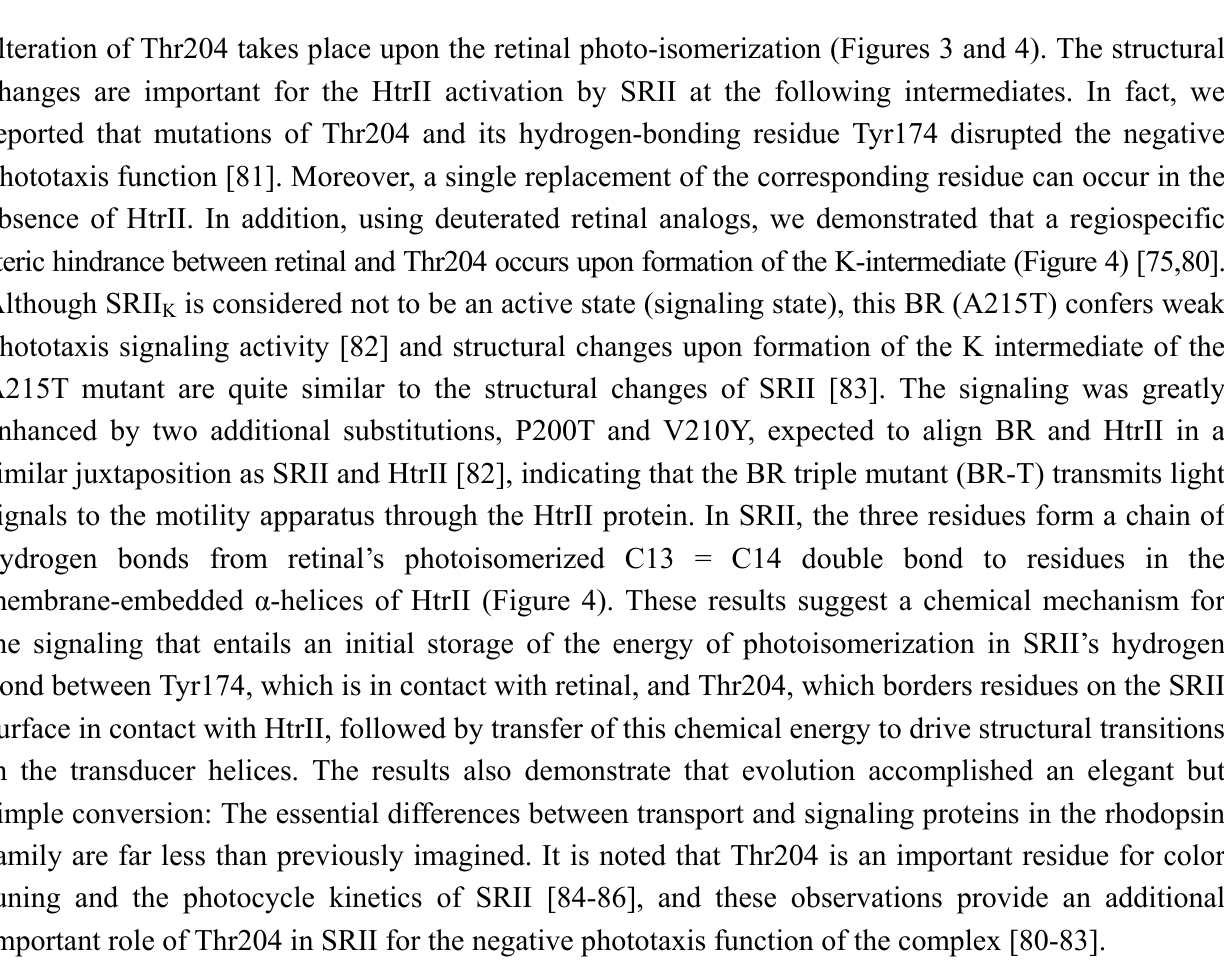
Figure 3. X-ray crystal structure of the SRII/HtrII complex (PDB code 1H2S) [17]. The